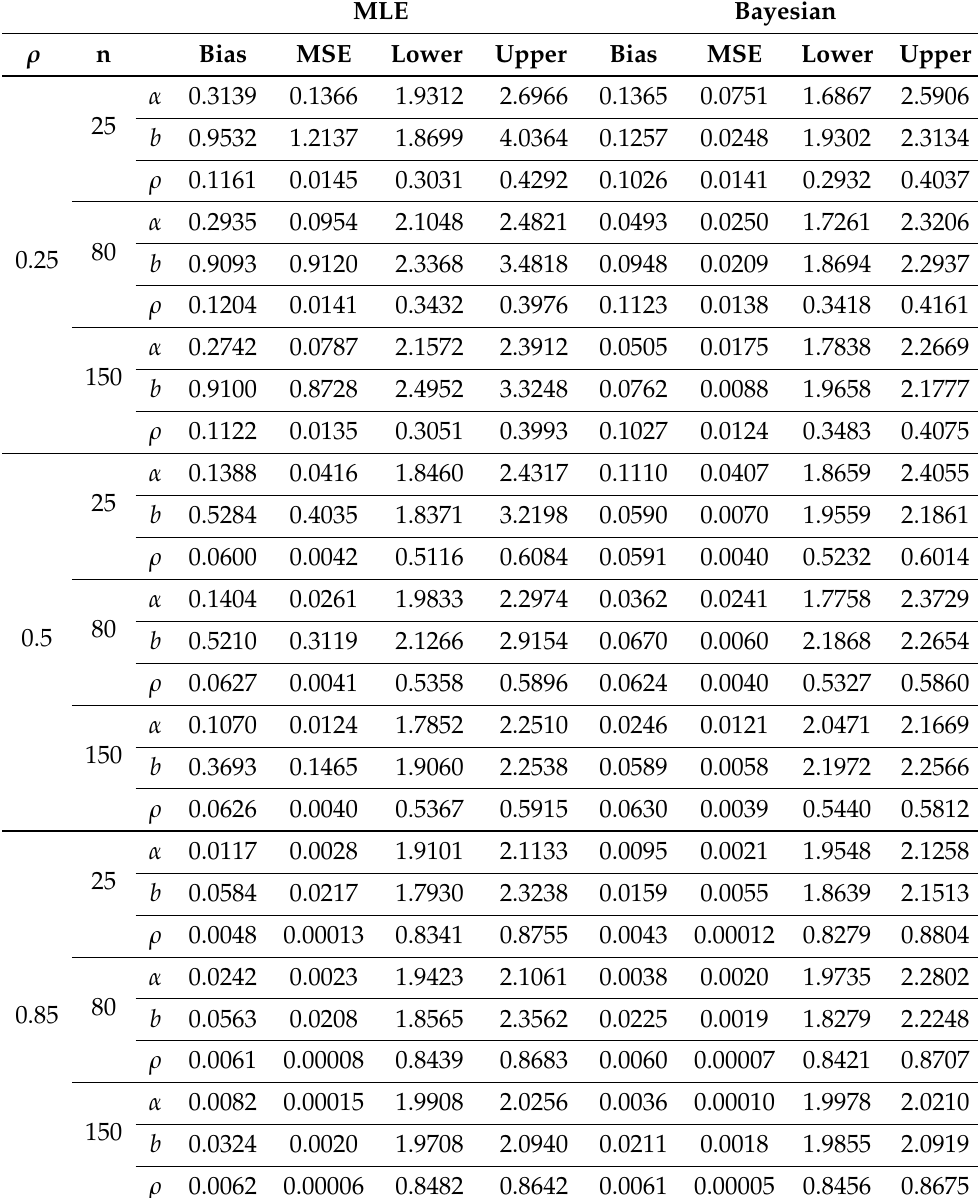
Table 3. Bias, MSE, Lower, and Upper of CIs for parameters of WMOE distribution: Case 2